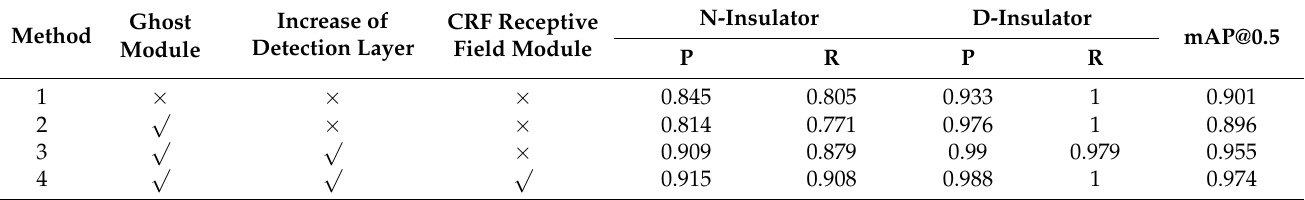
Table 2. Performance index comparison of ablation